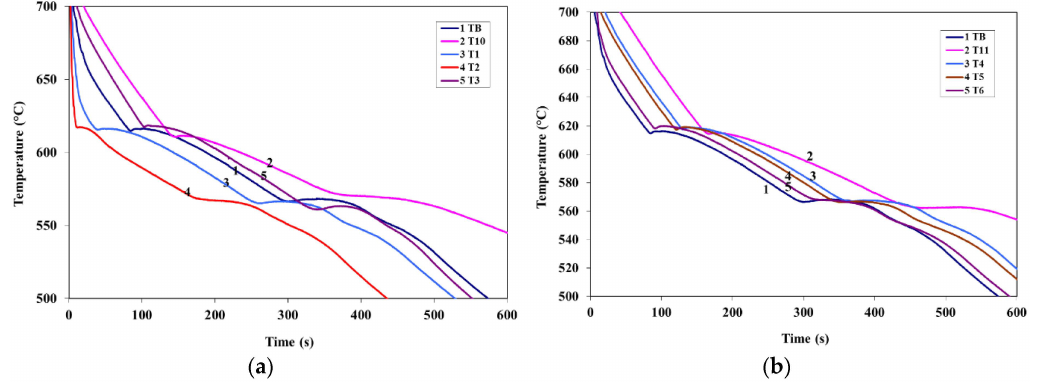
( a ) Solidification curves of La-containing alloys; ( b ) solidification curves of Ce-containing